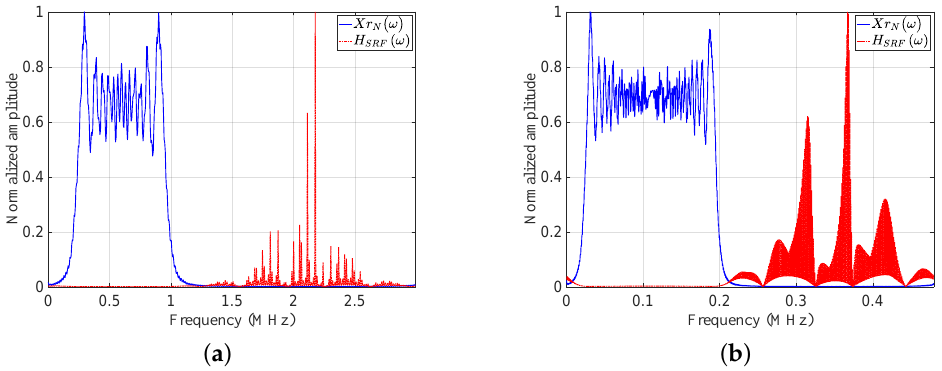
Figure 18. The frequency response Xr N ( ω ) , and H SRF ( ω ) : ( a ) an ultrasonic wave propagating through iron, and ( b ) an ultrasonic wave propagating through sea water.